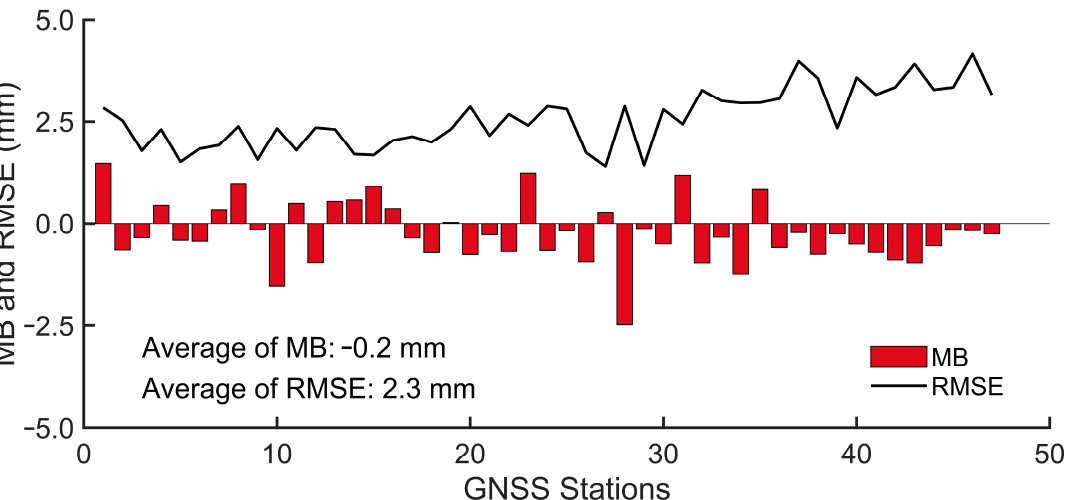
Figure 3. The MB and RMSE values of the GPS-PWV at 47 GNSS stations compared with the Radio- PWV from the adjacent meteorological stations. The red bars represent the MB, and the black line represents the RMSE.